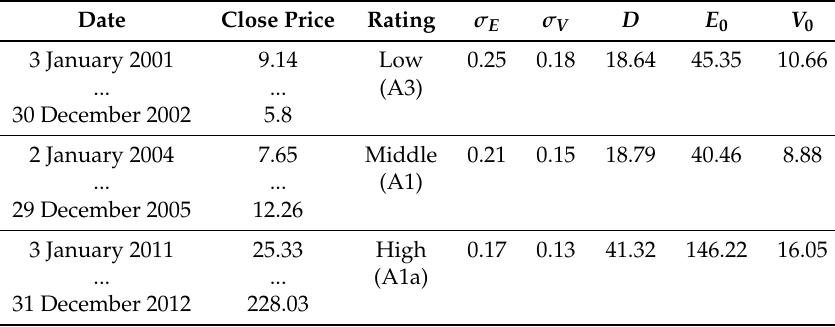
Table 1. The values, credit ratings, volatilities and debt of MTR.